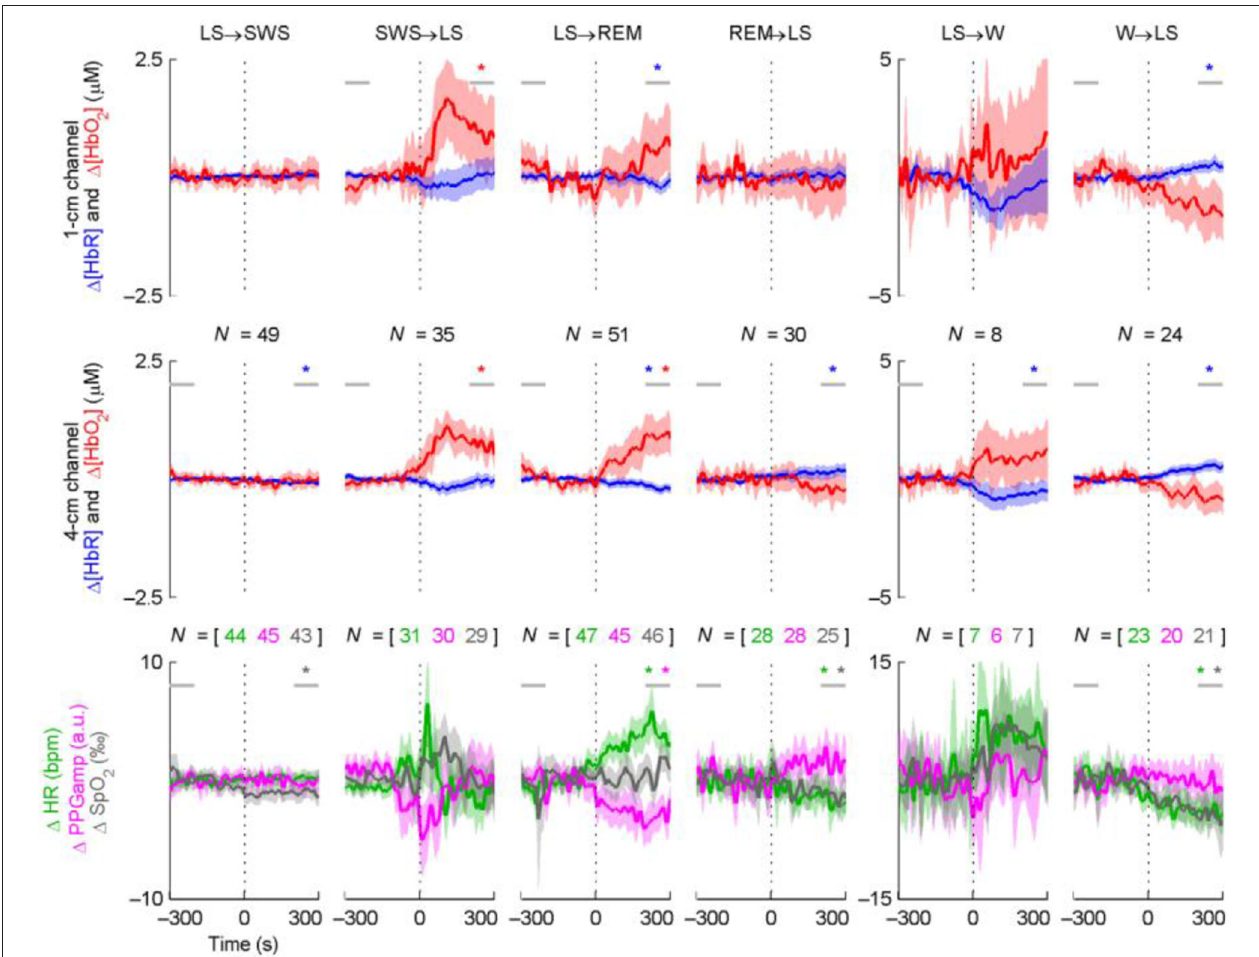
FIGURE 3 | Time course averages around sleep stage transitions. N indicates the number of transitions (vertical dotted line) averaged and is equal for the two NIRS channels. The shading indicates the 95% confidence interval of the mean. Statistically significant baseline changes are indicated with a star of the corresponding color; the horizontal gray lines indicate the 100-s periods the baseline comparison was based on. The results from the baseline comparisons are not directly comparable to the confidence intervals, since paired t -tests were used for the former. For graphical purposes, LFOs were removed from the signals by low-pass filtering (passband edge at 40 mHz). This did not affect the statistical tests or the overall behavior of the curves. Note the three different transition types (persistent changes, transient changes, or no changes at all) and the asymmetry of opposing transitions in terms of the magnitude and speed of changes (e.g., LS → WS vs. SW → RLS). 1 [HbR] and PPGamp generally change in the opposite direction compared to 1 [HbO 2 ] and HR. An example showing the changes of cerebral hemodynamics during the transition between different sleep stages adapted from Näsi et al.